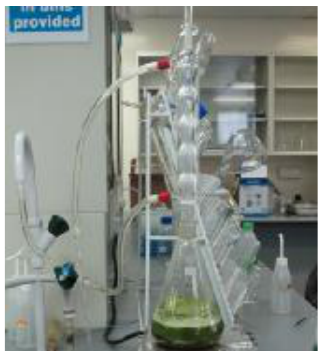
Figure 2. The Design of the Reflux Containing the Gotu Kola Fresh Leaves